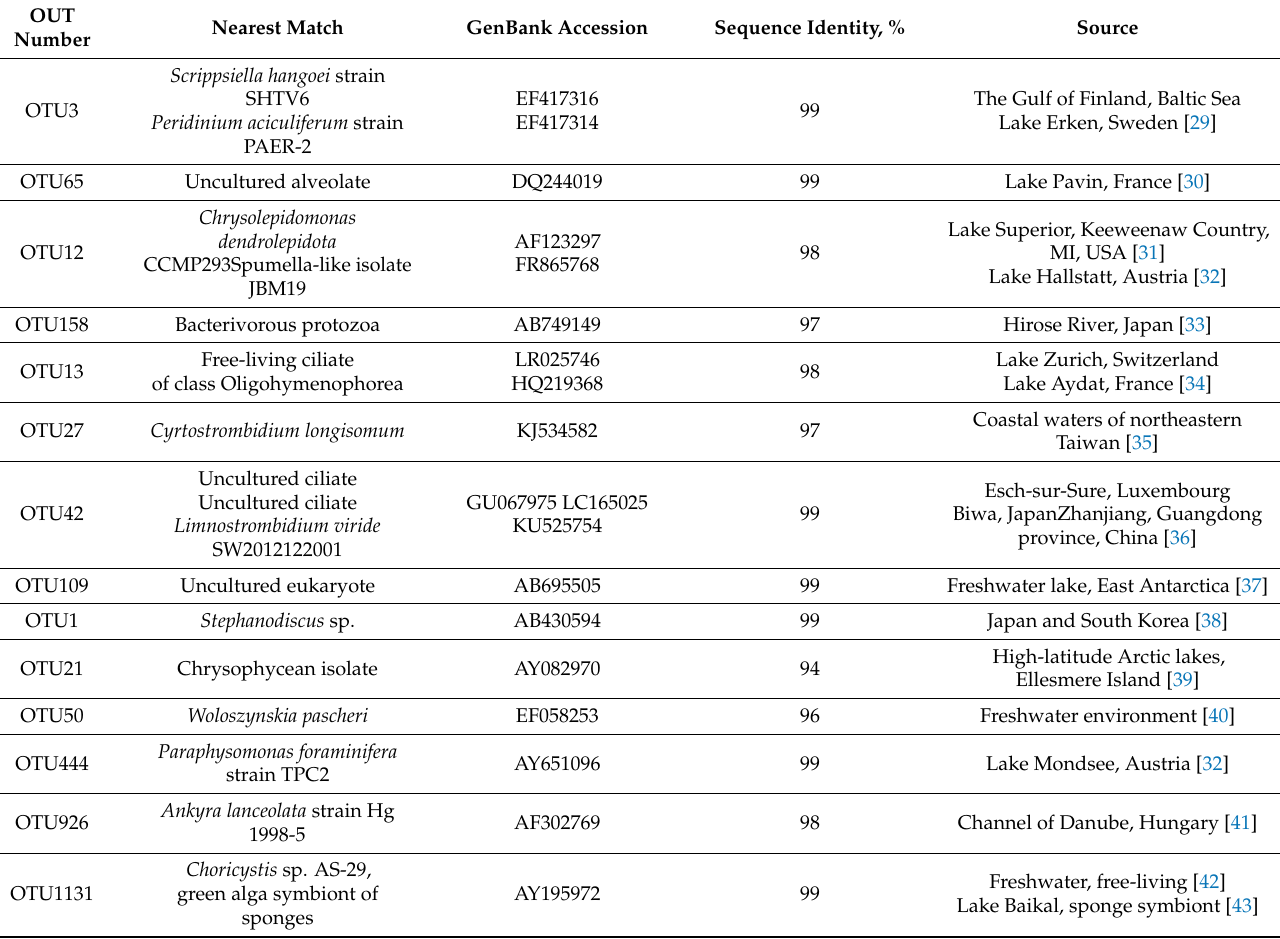
Table 5. Environmental sources of selected SSU sequences having high-similarity matches with OTUs from LL and